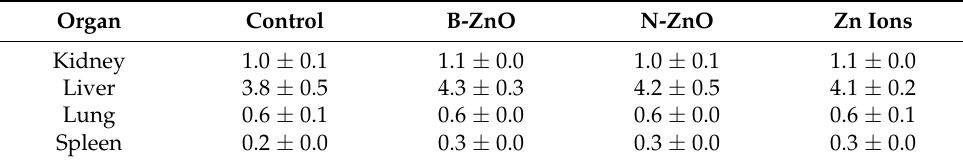
Figure 3. Changes in ( A ) body weight gain, ( B ) food intake, and ( C ) water consumption after 14-day repeated oral administration of B-ZnO, N-ZnO or Zn ions in rats. No significant differences among non-treated control and treated groups (B-ZnO, N-ZnO, and Zn ions) were found ( p > 0.05). Table 3. Organo-somatic indices of rats after 14-day repeated oral administration of B-ZnO, N-ZnO or Zn ions 1